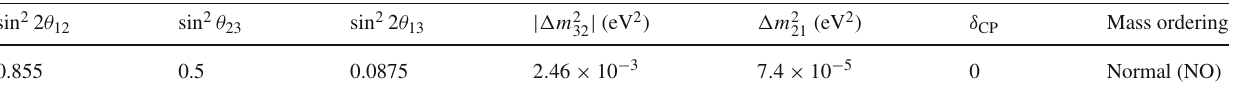
Fig. 2 Oscillograms of survival probabilities of ν μ (left panel) and ¯ ν μ (right panel) in the ( E ν , cos θ ν ) plane, using three-flavor neutrino oscillation framework in the presence of Earth matter (PREM profile [24]). We use the oscillation parameters given in